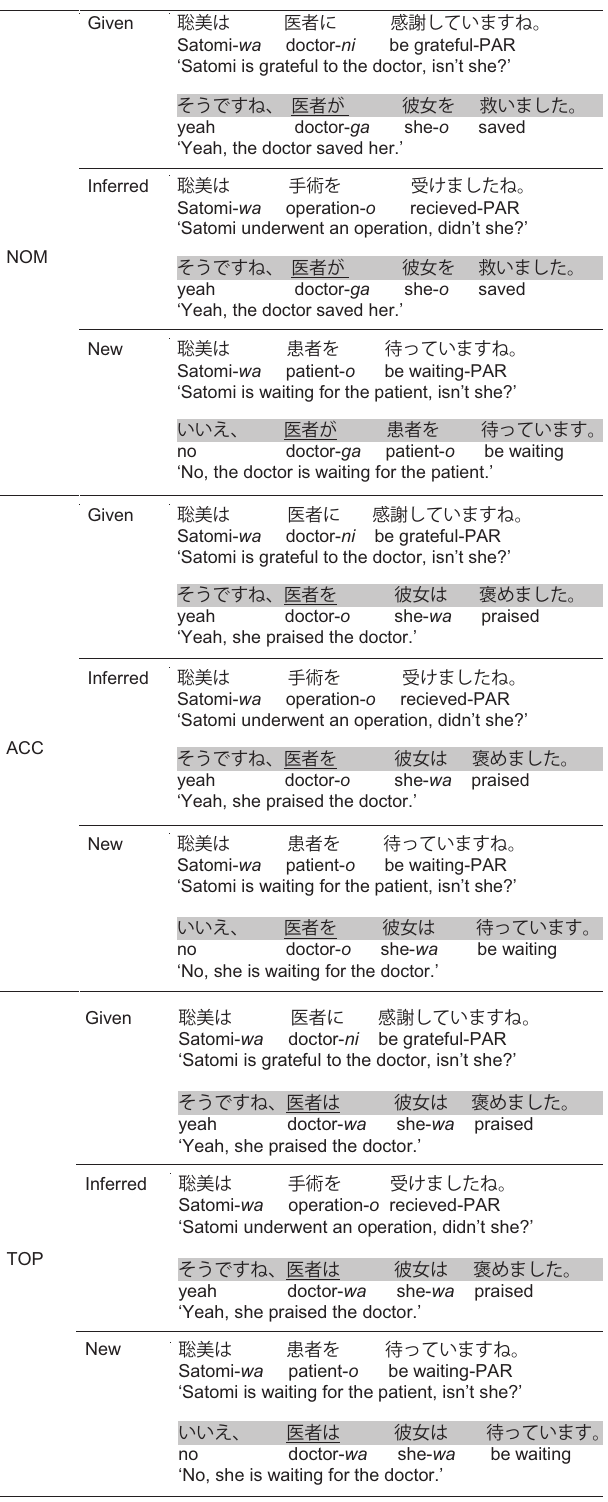
Table 3 | Examples of critical conditions in Experiment 2 for the factors marker ( ga ; o , wa ), and context (given, inferred, Contrastive